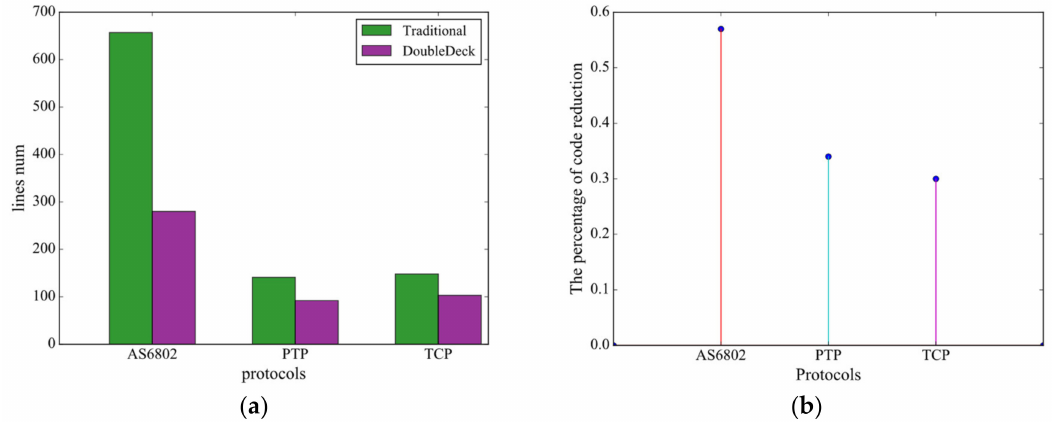
Figure 12. Comparison result between traditional method and DoubleDeck method. ( a ) Code amount; ( b ) the percentage of code